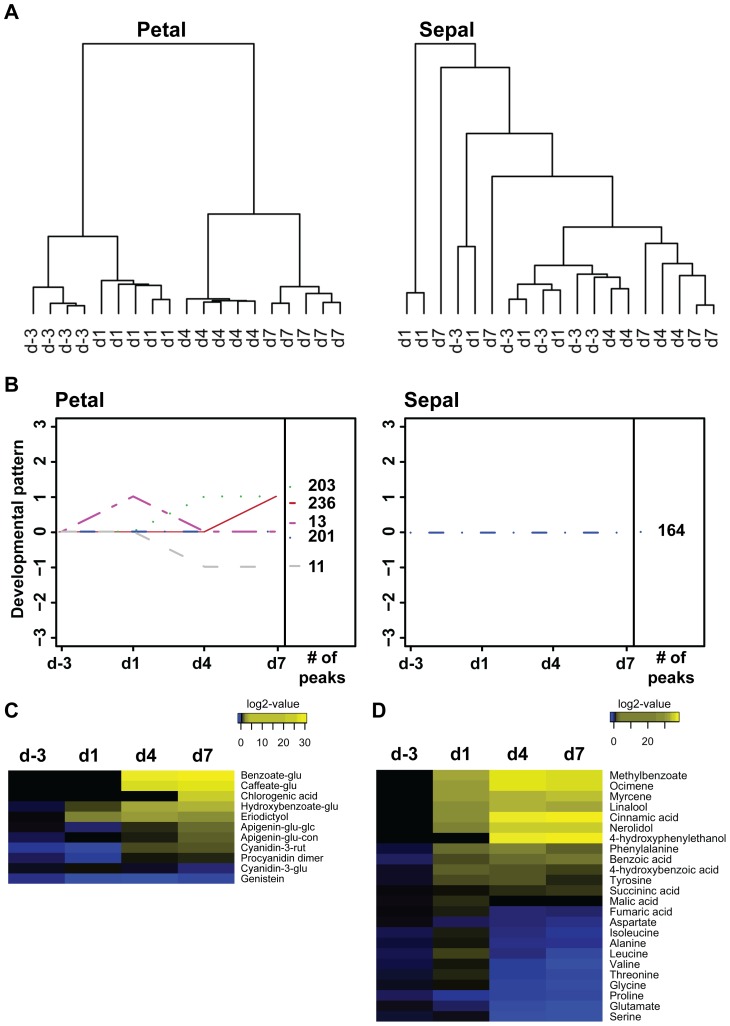
Remodeling of the petal and sepal metabolomes over flower development.(A) Cluster dendrogram showing the four stages of petal and sepal development. Samples were clustered according to their individual metabolomic profiles as measured by non-targeted liquid chromatography-mass spectrometry (LC-MS). (B) Grouping of peaks detected by non-targeted LC-MS analysis based on their developmental profile. Using a one-way ANOVA, three hypotheses were tested: H0: µd-3 = µd1, H0: µd1 = µd4, H0: µd4 = µd7. A score was attributed for each test. If the gene expression was not significantly different (p-value>0.05), the score = 0. If it was significantly up-regulated (p-value<0.05), the score = 1. If it was significantly down-regulated (p-value<0.05), the score = −1. Genes were grouped based on the combination of scores for the three tests. The number of peaks in each developmental pattern is indicated next to the graphs. Heatmap of (C) metabolites putatively identified by ion trap LC-MSn and of (D) metabolites measured by gas chromatography-mass spectrometry in snapdragon petals. Metabolite levels were expressed relative to the average value for that metabolite in d-3 samples and log2-transformed. Log2-transformed values were averaged for each stage. Yellow indicates an increase in metabolite abundance and blue a decrease.